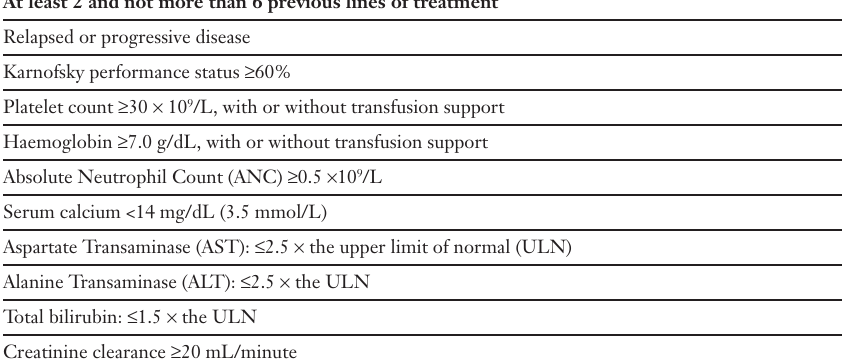
Major eligibility